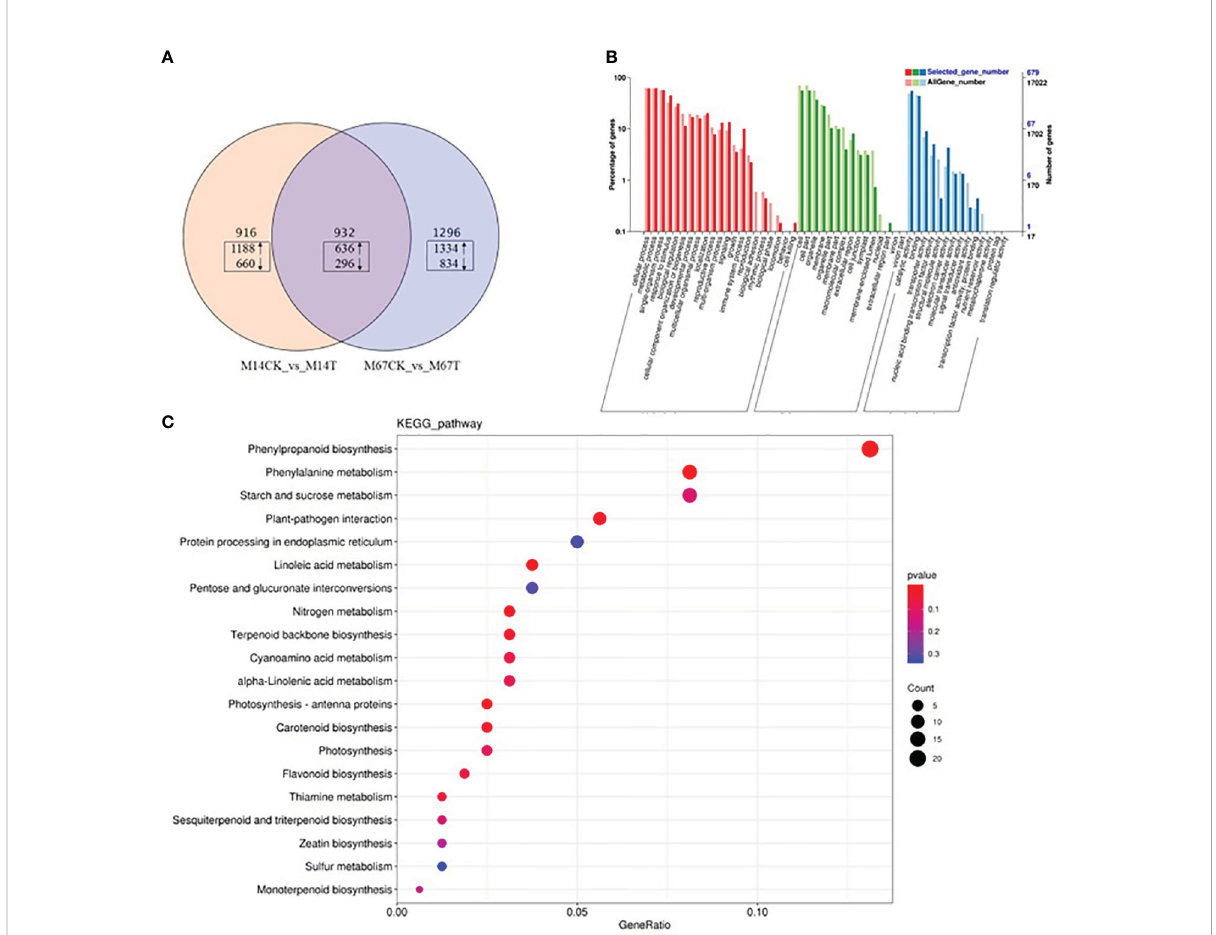
FIGURE 7 Transcriptome analysis of cucumber leaves with semilethal in M67 and M14 under low-light stress. M67: tolerant line. M14: sensitive line. (A) Venn diagram of DEGs under low-light. The DEGs sets (M14CK Vs M14T and M67CK Vs M67T) were analyzed by using the Venn method and the numbers in box marked in the diagram indicate the number of common genes signi fi cantly up- (upward arrows) and down-regulated (downward arrows) among the three DEG sets (log2-fold change ≥ 1.5 and FDR-corrected P-value ≤ 0.001). (B) GO enrichment analysis result of 932 DEGs with fold change >2. (C) KEGG enrichment of 932 DEGs. The bubble diagram shows the degree of enrichment of KEGG terms in three categories. By default, the top 20 GO terms with the lowest Q-values were used in the diagram. The X-axis represents the enrichment ratio, and the Y-axis denotes the KEGG pathway. The size of bubbles indicates the number of genes annotated to a certain KEGG pathway, and the color represents the Q-value, where the redder the color is, the smaller the Q-value